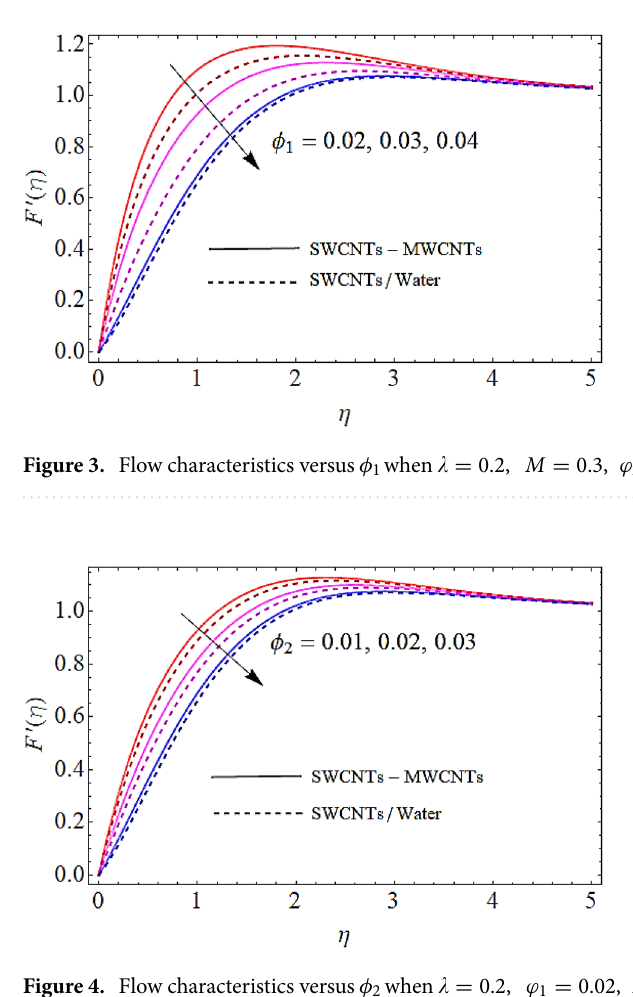
Figure 4. Flow characteristics versus φ 2 when (cid:31) = 0.2, ϕ 1 = 0.02, M = 0.3, K = 0.7 .